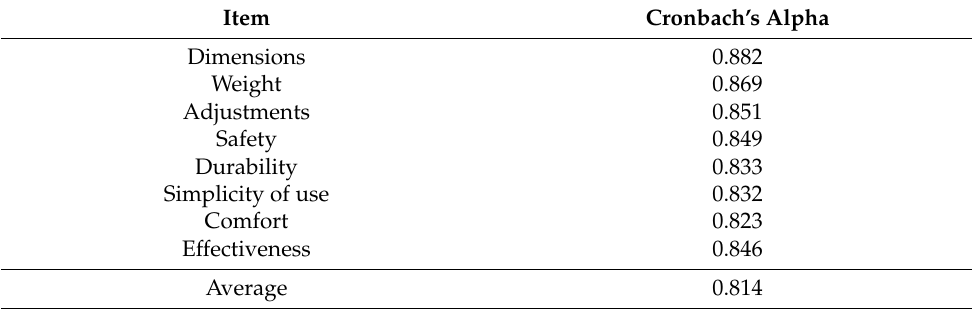
Table 10. Cronbach’s Alpha internal agreement between satisfaction